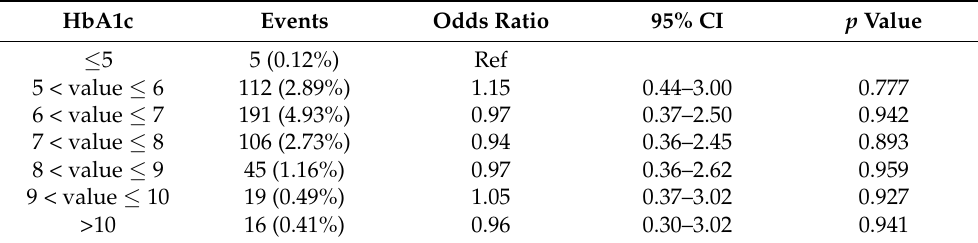
Table 5. Binary logistic regression models for hypoglycemia in different HbA1c quartile among elderly patients with dementia and type 2